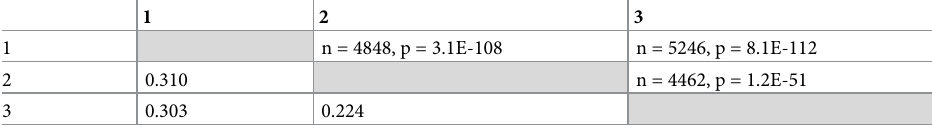
� Upper triangle: n, number of pairwise comparisons, p, Pearson r statistical significance; lower triangle: Pearson